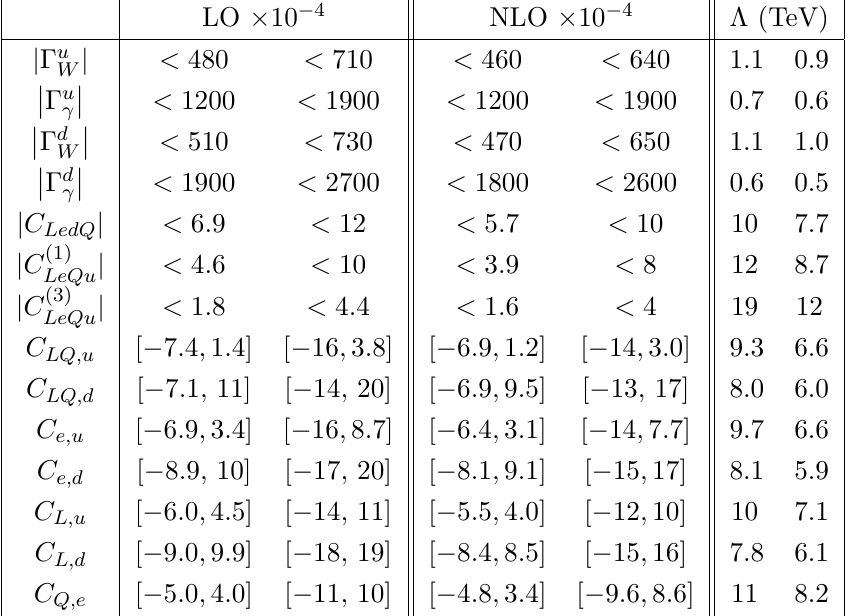
Table 3 . 90% CL bounds on the coe(cid:14)cients of SM-EFT operators that contribute to CC and NC Drell-Yan production, and the corresponding estimates of the scale (cid:3), assuming C i (cid:17) v 2 = (cid:3) 2 . The bounds on the (cid:12)rst and second columns use, respectively, SM-EFT cross sections at LO and NLO in QCD. (cid:3) is extracted from the NLO bounds, and, for asymmetric limits, the weaker limit is used. The bounds are obtained by turning on all operators at the scale (cid:22) 0 = 1 TeV, but